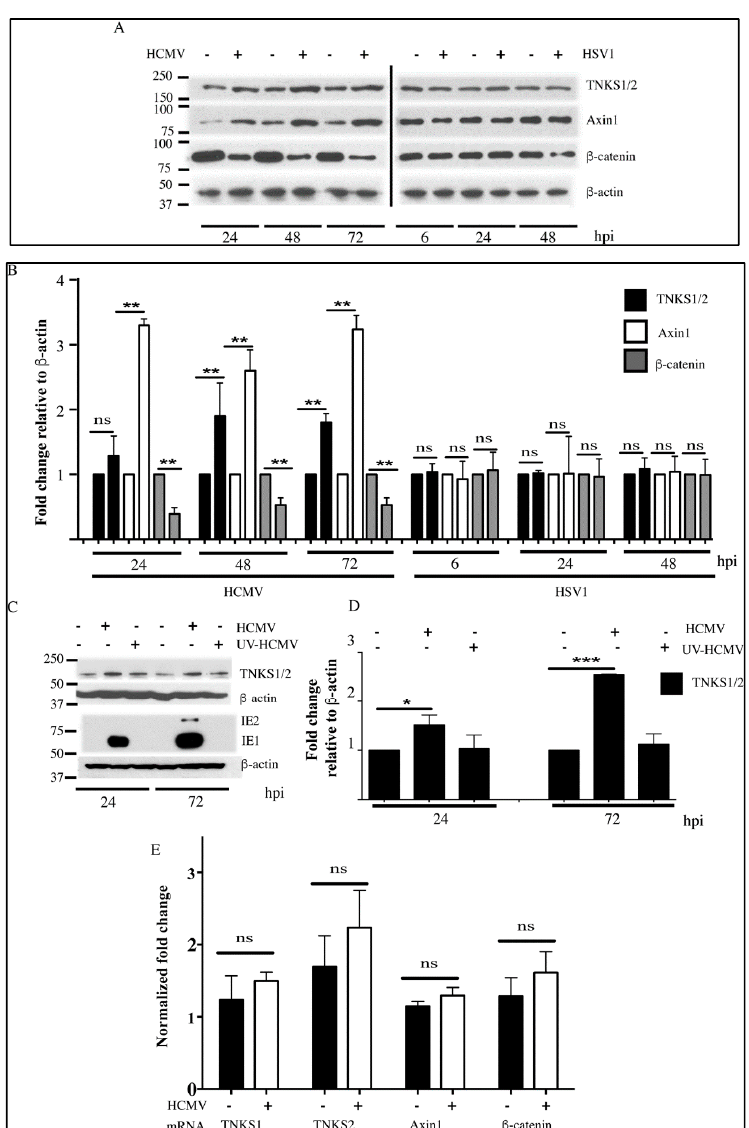
Figure 1 . TNKS is induced by human cytomegalovirus (HCMV) but not herpesvirus (HSV) infection. ( A ) Western blot showing protein profile in response to HCMV and HSV infection at the indicated hpi. HFFs were infected with HCMV Towne or HSV1 at multiplicity of infection (MOI = 1) and harvested at indicated times; ( B ) Shows the quantification of the same from three independent experiments with standard error of mean ( C ) Western blot indicating requirement of active HCMV replication for TNKS accumulation. HFFs were infected with HCMV Towne or UV-inactivated HCMV Towne at MOI = 1 and harvested at 72 hpi; ( D ) Shows the quantification of the same from three independent experiments with standard error of mean ( E ) qRT-PCR showing mRNA levels of TNKS 1 and 2, Axin 1 and β -catenin at 24 hpi in infected HFFs. Quantification is averaged from four independent experiments with standard error of means. * indicates p value < 0.05, ** indicates p < 0.01, and *** indicates p < 0.001 and ns indicates non-significance.